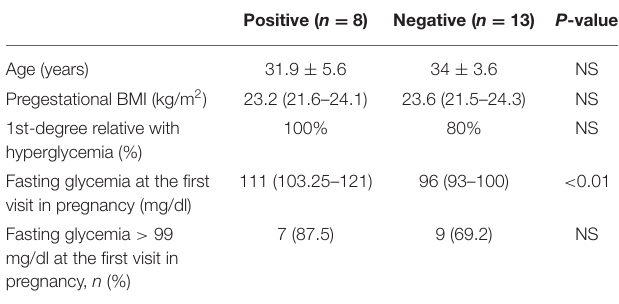
TABLE 3 | Clinical features of the women tested for GCK-MODY, based on the result of the genetic